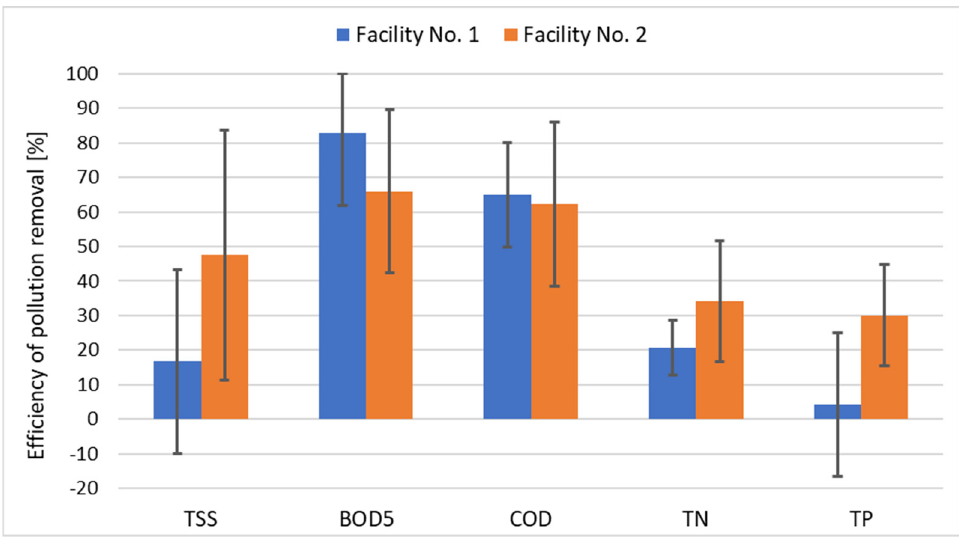
Figure 2. Average efficiency of pollutant removal in two studied household WWTPs.